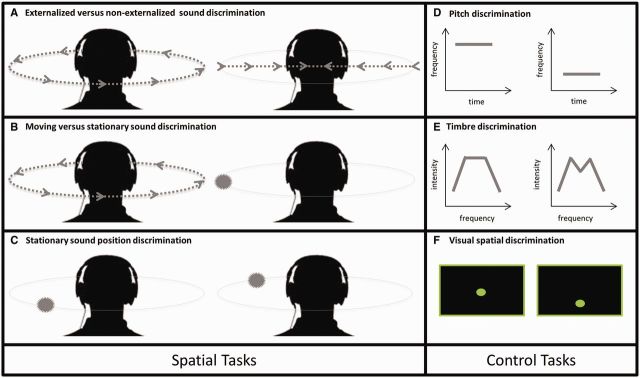
Schematic representation of experimental battery. Auditory spatial tasks are presented in the left hand panels (A–C); control tasks are presented in the right hand panels (D–F). Within each test panel, a stimulus pair corresponding to an experimental trial is shown; on a given trial, paired stimuli were presented sequentially with an intervening 1-s gap. In auditory spatial tests, perceived stimulus locations externalized in the azimuthal plane are shown; arrowed lines represent perceived trajectories of sound motion and filled circles represent perceived locations of stationary sounds. See text for details.